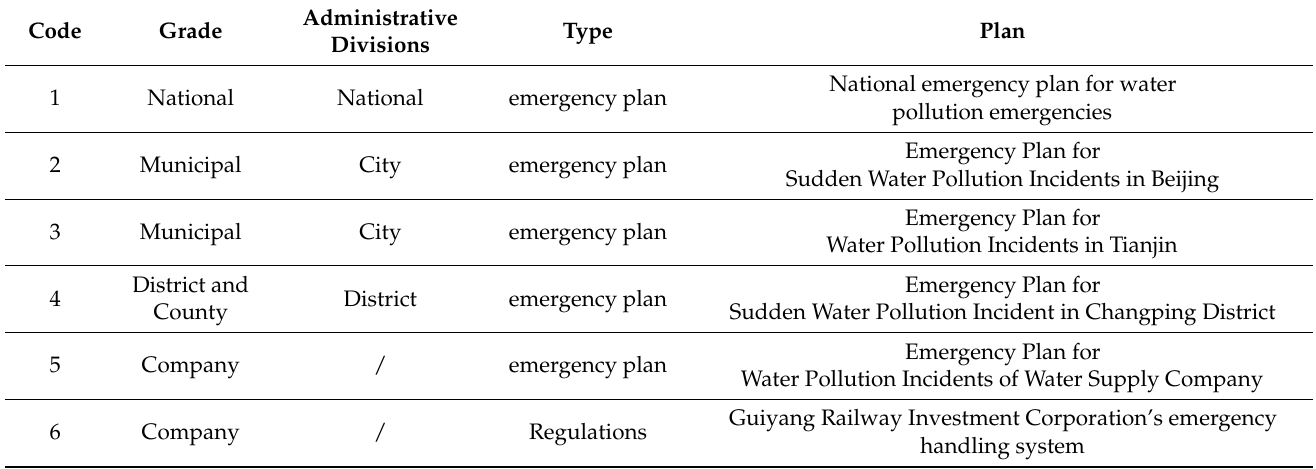
Table 1. Part of the pre-plan hierarchical management